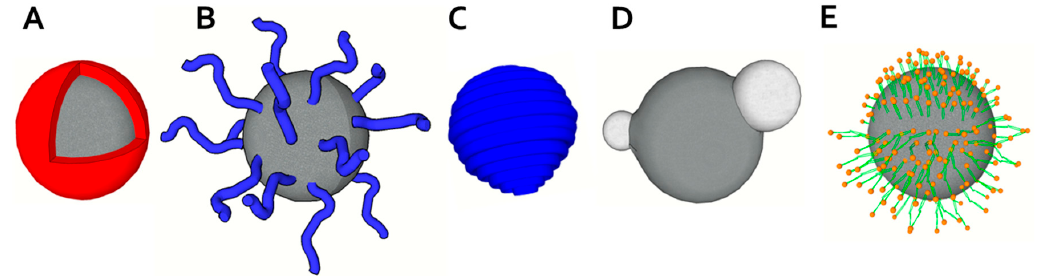
Figure 2. Structures of magnetic particles and their coating schemes. ( A ) Core-shell magnetic particle; ( B ) End-grafted polymer coated magnetic nanoparticle; ( C ) Magnetic particle fully encapsulated in polymer coating; ( D ) Heterodimer magnetic particle; ( E ) Hydrophobic magnetic particle encapsulated within lipid monolayer (upper part) and hydrophilic magnetic particle within lipid bilayer (modified from [41] with permission).